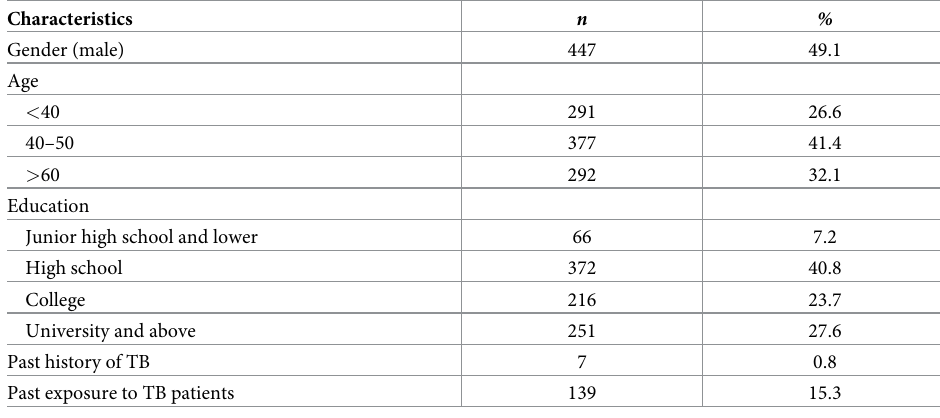
Table 1. Demographic characteristics of the participants ( n =